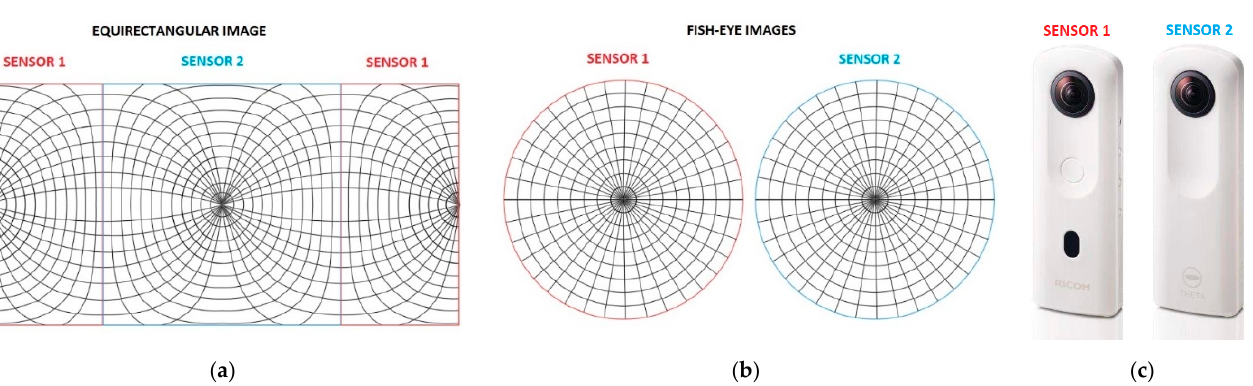
Figure 2. Geometric configuration of the equirectangular image ( a ) using fisheye lenses ( b ) and generated by the Ricoh Theta SC2 ( c ).